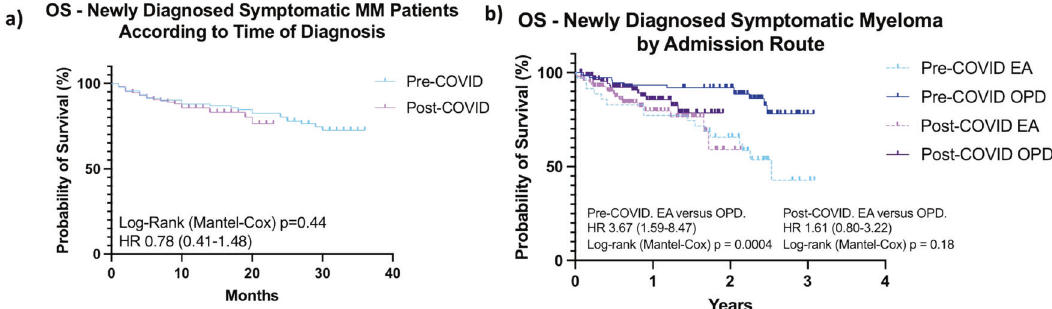
Fig. 7 Kaplan-Meier estimates of overall survival (OS) of patients with symptomatic MM. Patient diagnosed from 1st January 2019 – 31st January 2020 (Pre-COVID, n = 93) and from 1st February 2020 – 31st July 2021 (Post-COVID, n = 172). a Overall survival of newly diagnosed